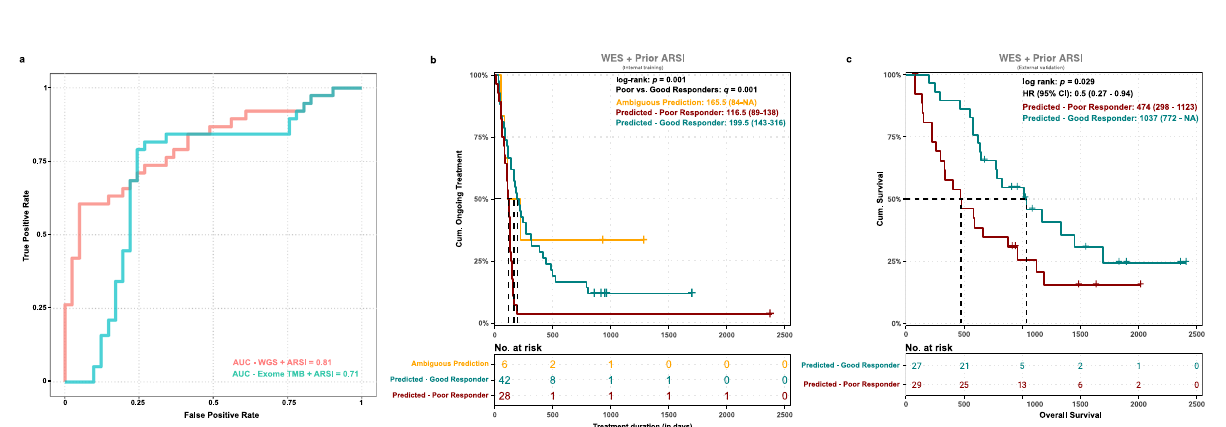
Fig. 8 | Predictive values of WES-based clinicogenomics model. a ROC curves andAUCsofWGSclinicogenomicsandexome-only(WES)clinicogenomicsmodels in LOOCV. b Survivalanalysis using ARSI-treatment duration(indays)and whether patientswerestillcurrentlyreceivingARSI(event)usingthethree-groupschemeof poor,goodandambiguouspredictorsfortheWES(TMB)+priorARSIclassi fi cation model on the internal validation cohort ( n =76). Survival curves were visualized using the Kaplan-Meier method and hazard ratios were calculated using Cox